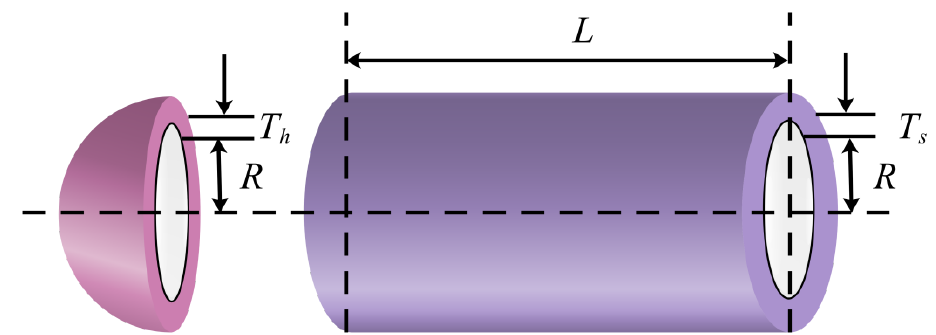
Figure 10. The construction of the pressure vessel design problem.